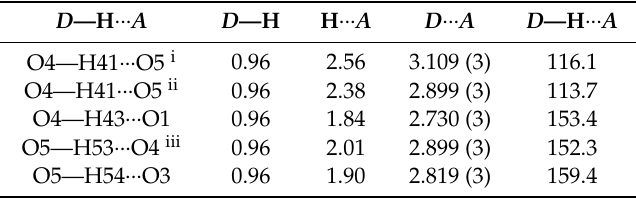
Table 5. Selected hydrogen-bond distances (Å) and angles ( ◦ ) in Co-rich köttigite. D —H ··· A